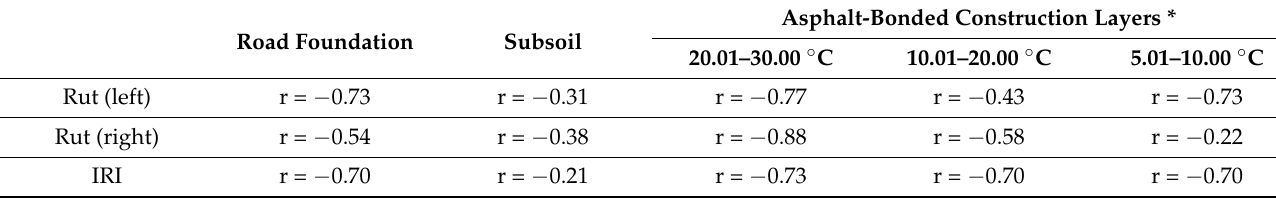
Table 3. Overview of Pearson coefficient for the road construction